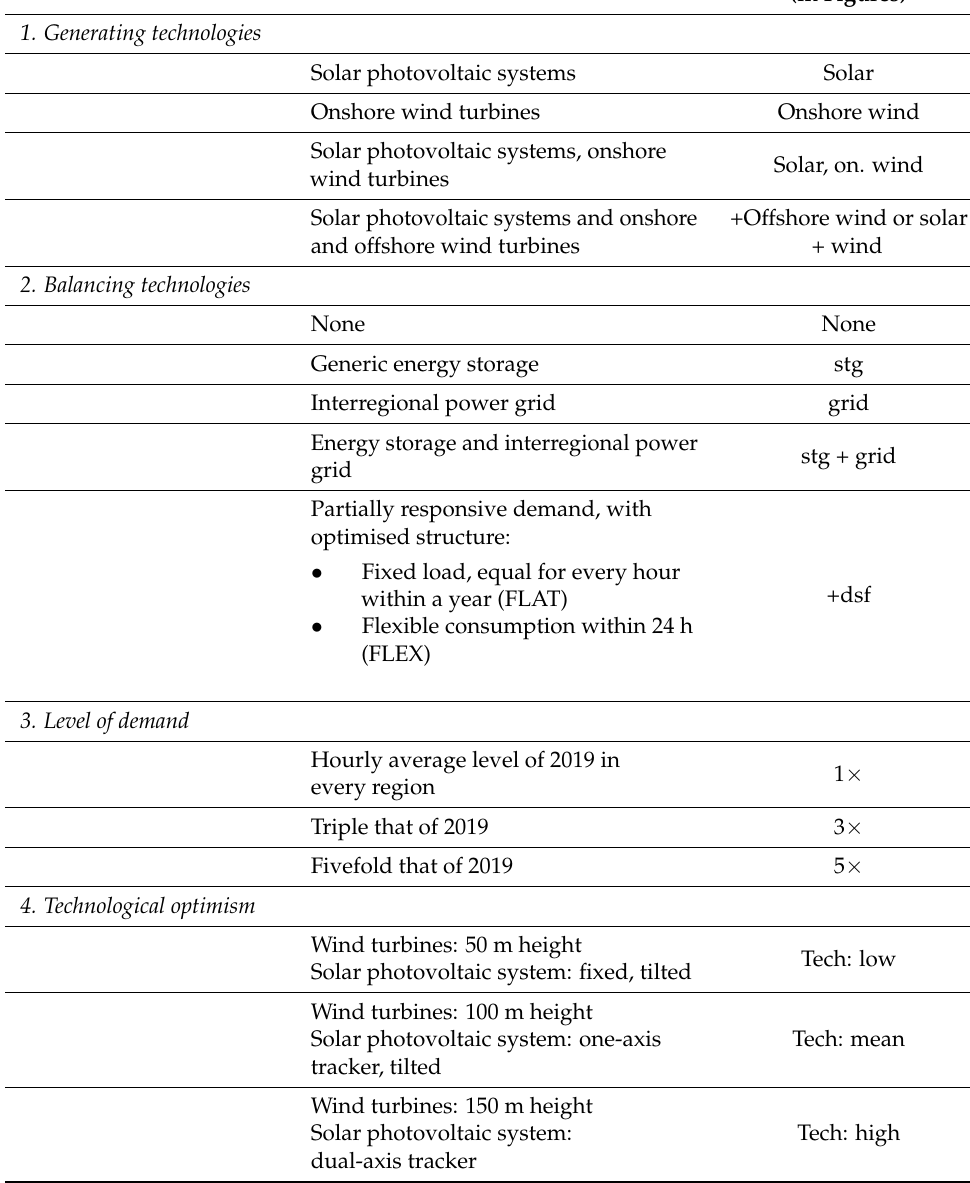
Table 2. Four branches of